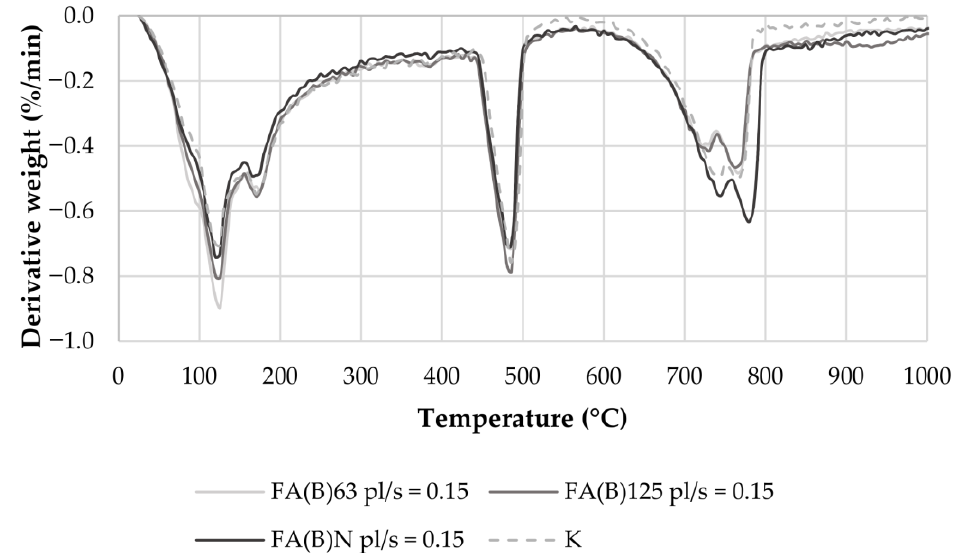
Figure 9. Derivative thermogravimetric (DTG) curves of mortars with a 15% addition of sieved fly ash (FA(B)63 or FA(B)125) compared with the results of mortars with a 15% addition of untreated fly ash (FA(B)N).